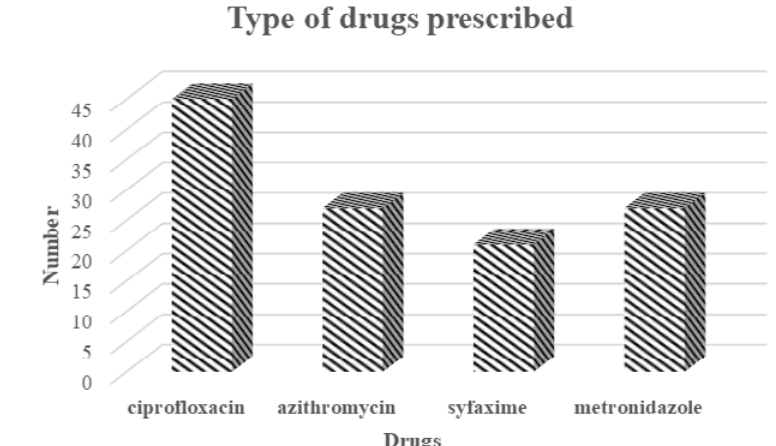
Figure 2. Drugs prescribed for the patients understudy